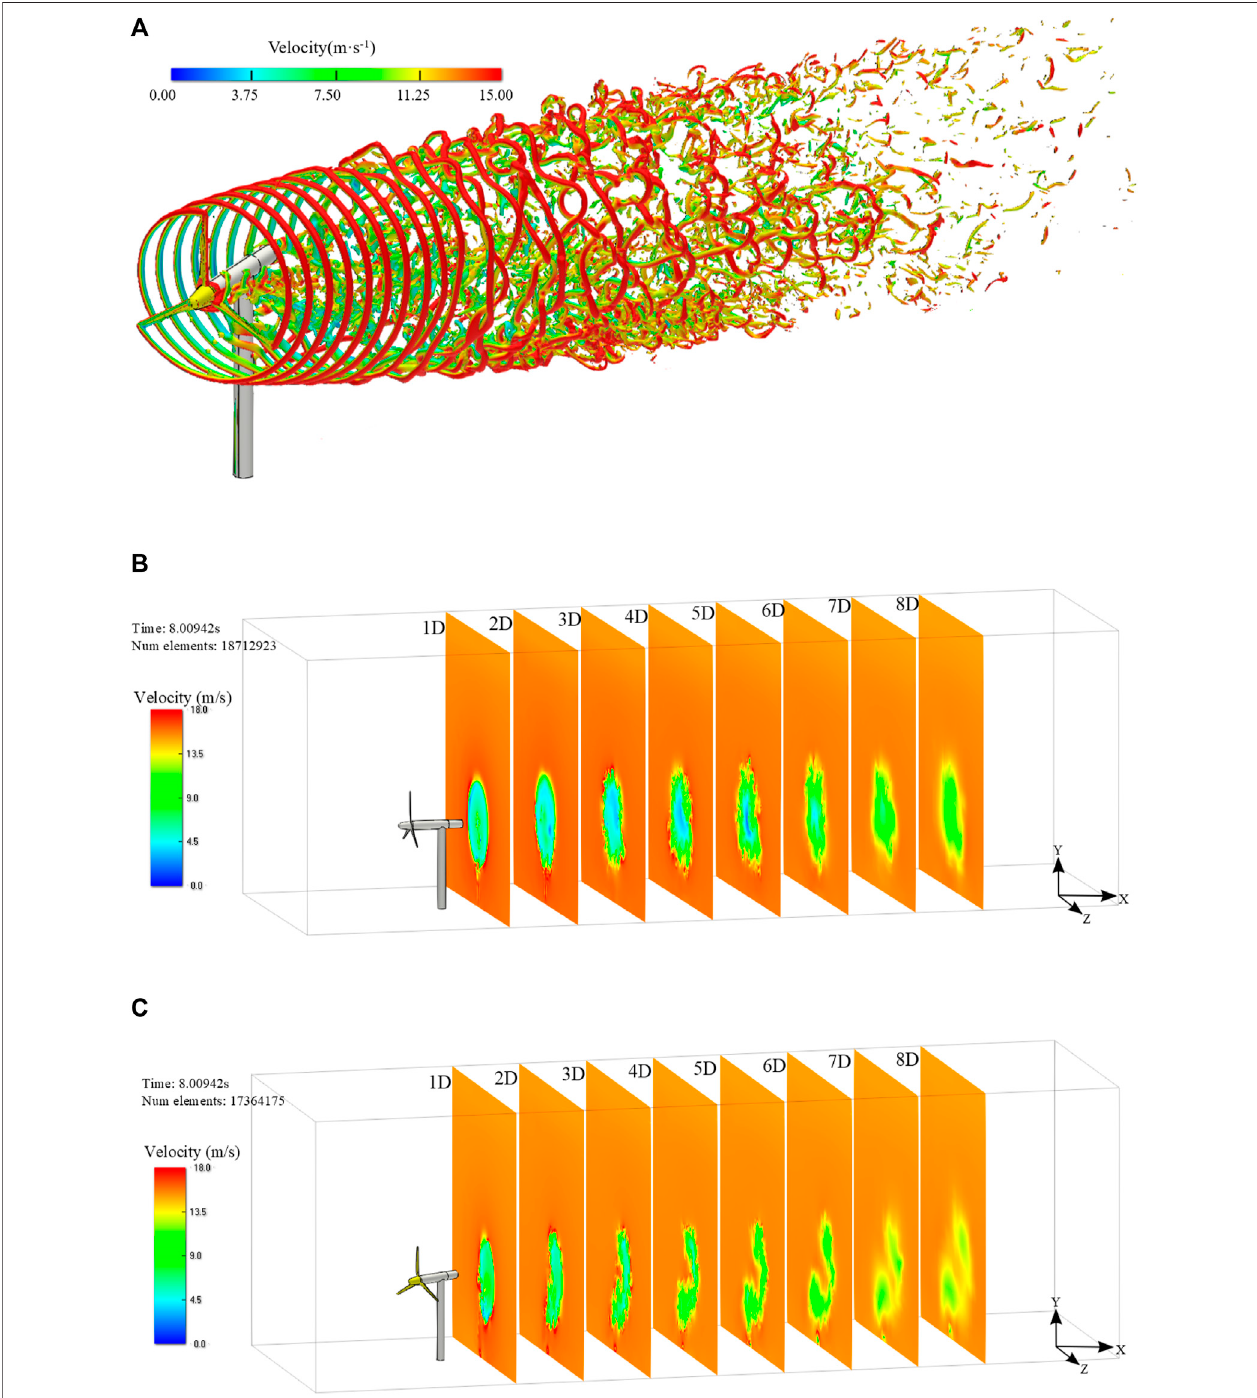
FIGURE8| Instantaneouscontour: (A) Wakestructurebehindthewindturbineunder ϒ =30 ° ; (B) Velocitycontourofthedifferentvertical sectionunder ϒ =0 ° ; (C) Velocity contour of the different vertical section under ϒ = 30 ° .